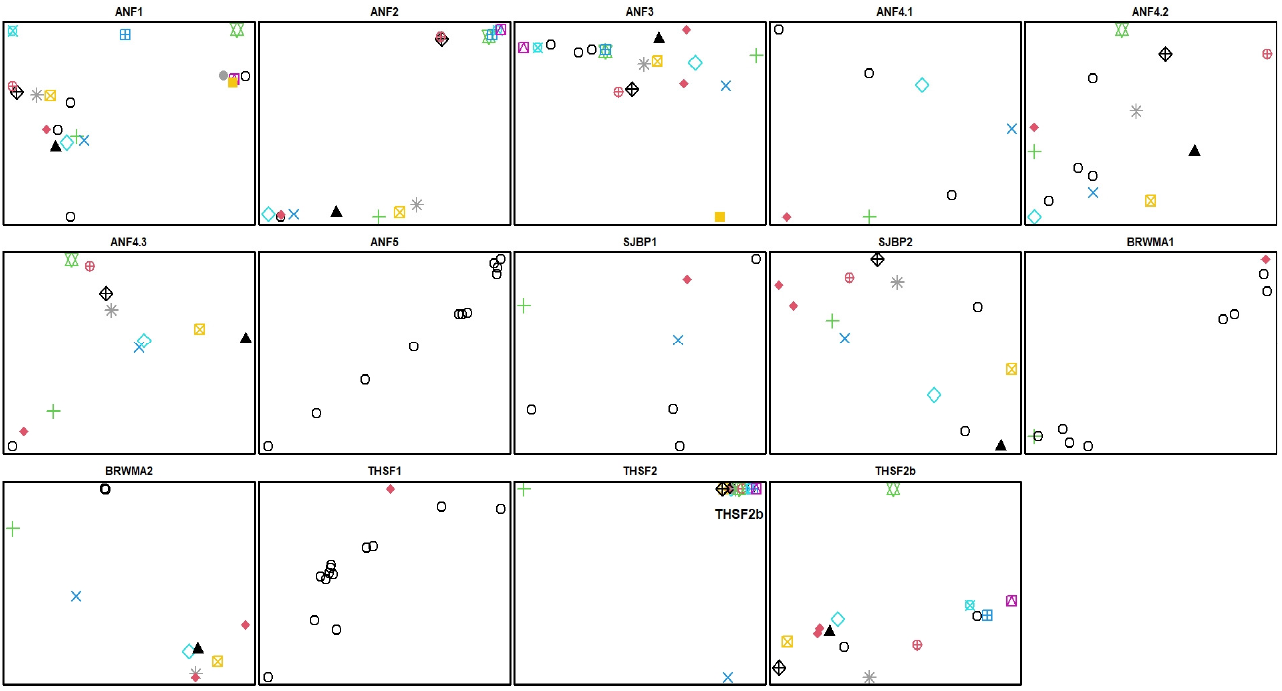
Figure 8. Spatial distribution of S. floridana clones and individuals with unique profiles within studied populations (see Figure 2 for locations) based on longitude ( x -axis) and latitude ( y -axis). Symbols represent each sampled individual. Within each population, ramets belonging to the same clone possess the same symbol. The last panel, THSF2b, shows the spatial distribution of a subset of THSF2 data. ANF4 was divided among three sampling sites because of its broad spatial distribution.